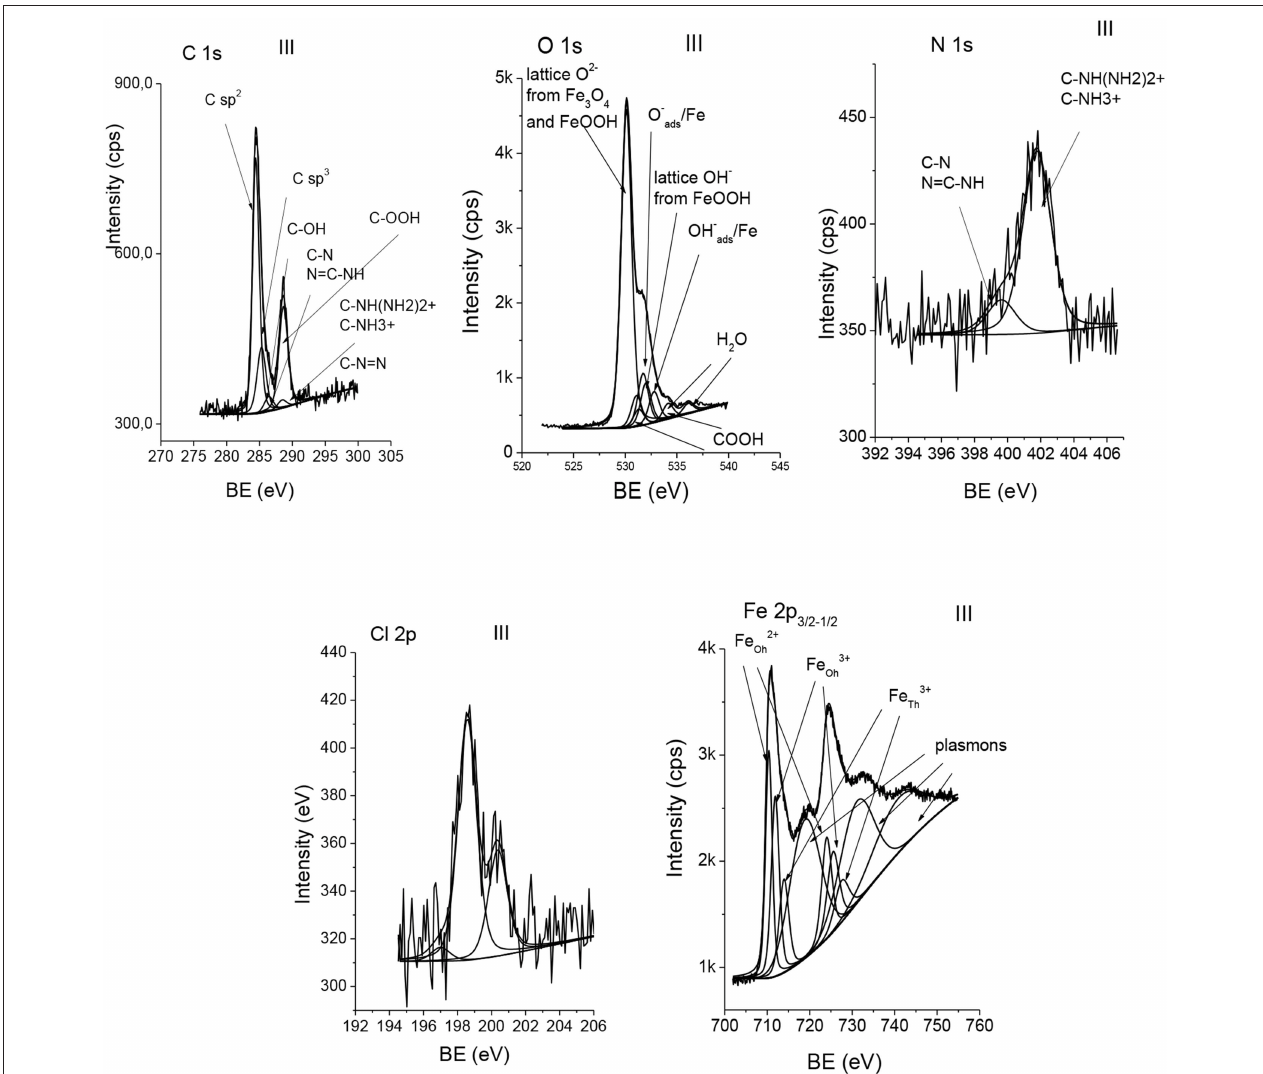
FIGURE 4 | The XPS C 1s, O 1s, N 1s, Cl 2p, and Fe 2p spectra fitted to different chemical forms for exemplary Fe 3 O 4 f-MNPs III.